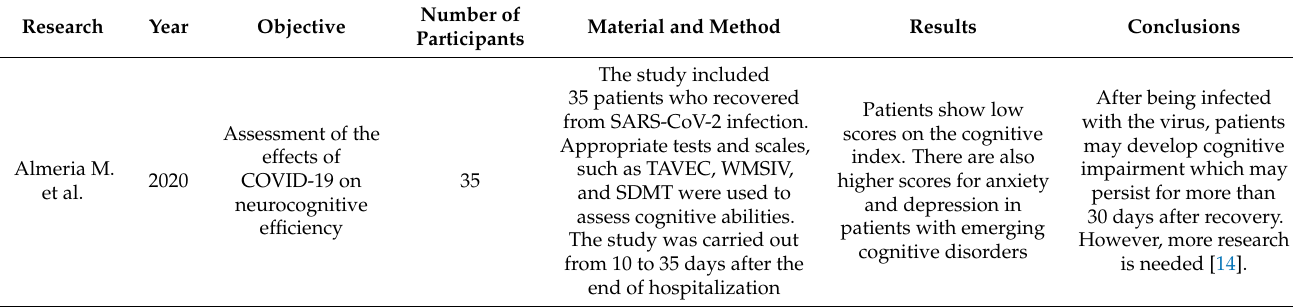
Table 3. The main effects of COVID-19 on the nervous